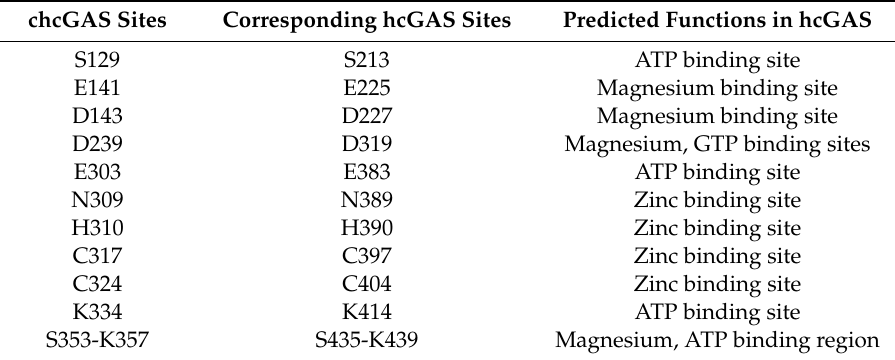
Table 2. The conserved sites and predicted functions in both chcGAS and hcGAS.